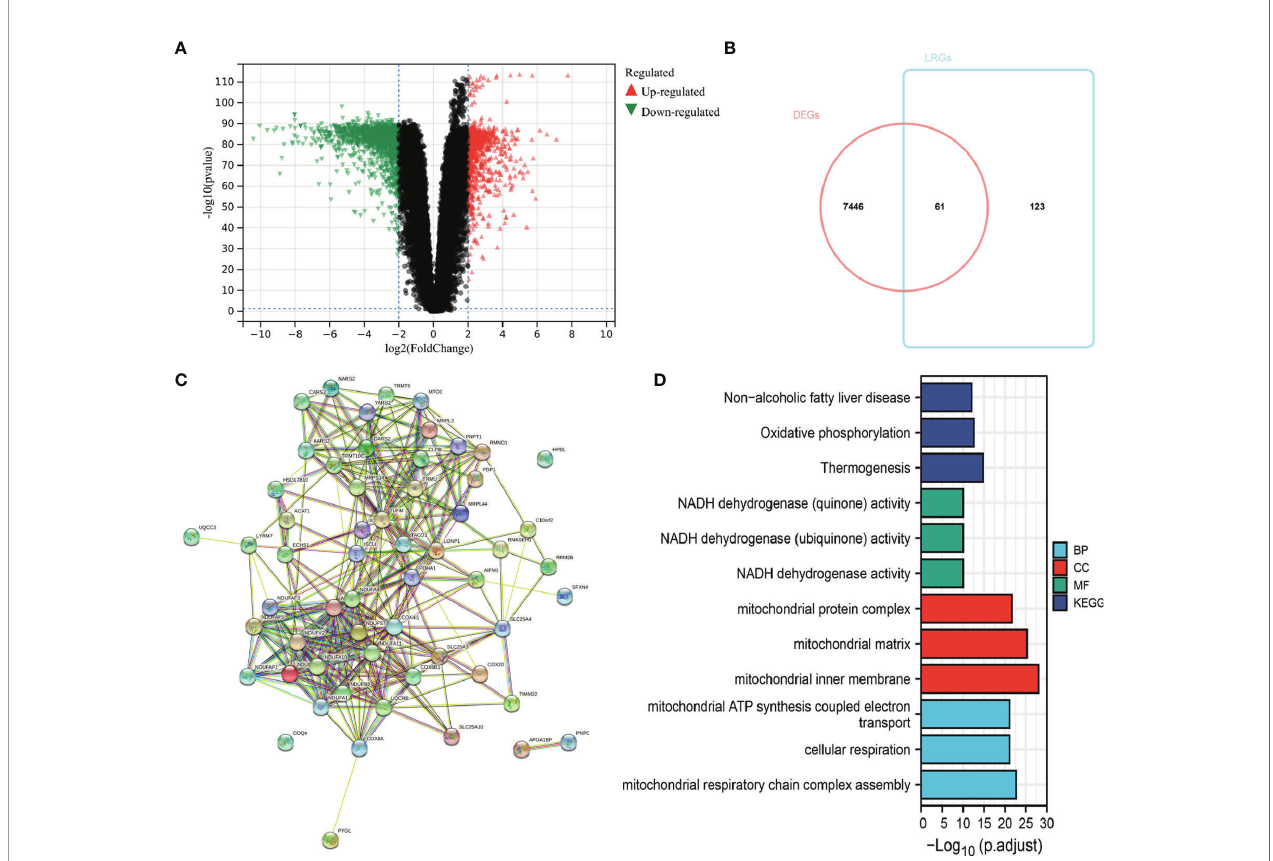
FIGURE 2 | Identi fi cation of differentially expressed LRGs in TCGA cohort and functional enrichment analysis. (A) Volcano plot showing the DEGs between 471 SKCM and 557 non-tumor healthy samples. (B) Venn diagram showing the intersection of DEGs and LRGs. (C) The PPI network of differentially expressed LRGs. (D) GO and KEGG analyses of differentially expressed